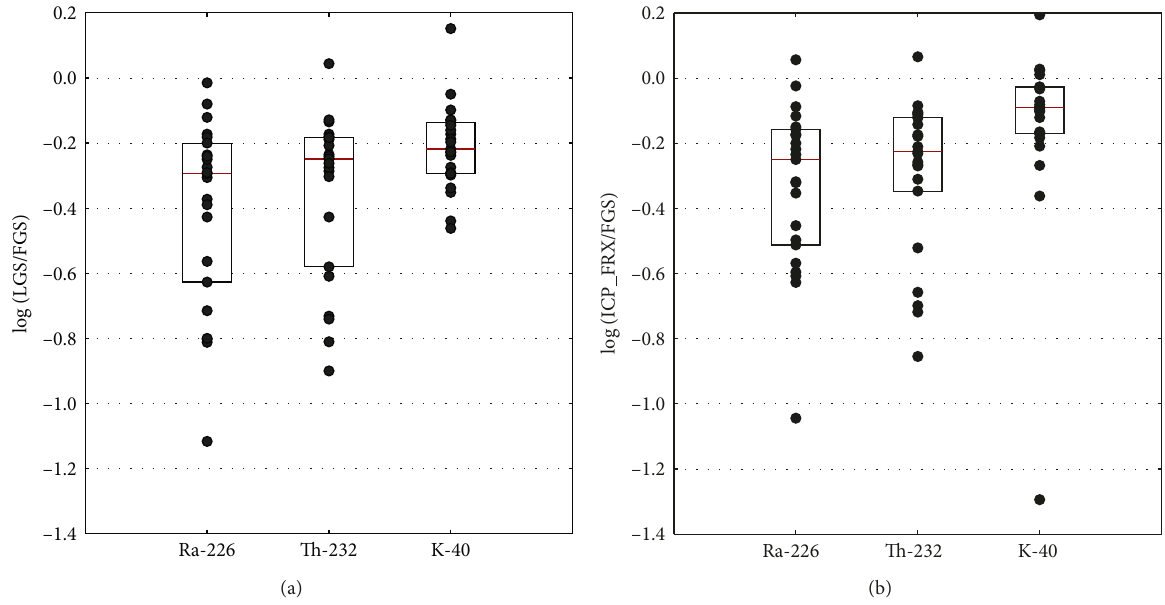
Figure 3: Combined boxplots (quartiles) and raw data plots of logarithms of radioisotopes estimations from laboratory analyses to those from field measurements: (a) comparison of laboratory gamma spectrometry (LGS) to field gamma spectrometry (FGS); (b) comparison of estimations from ICP and XRF to